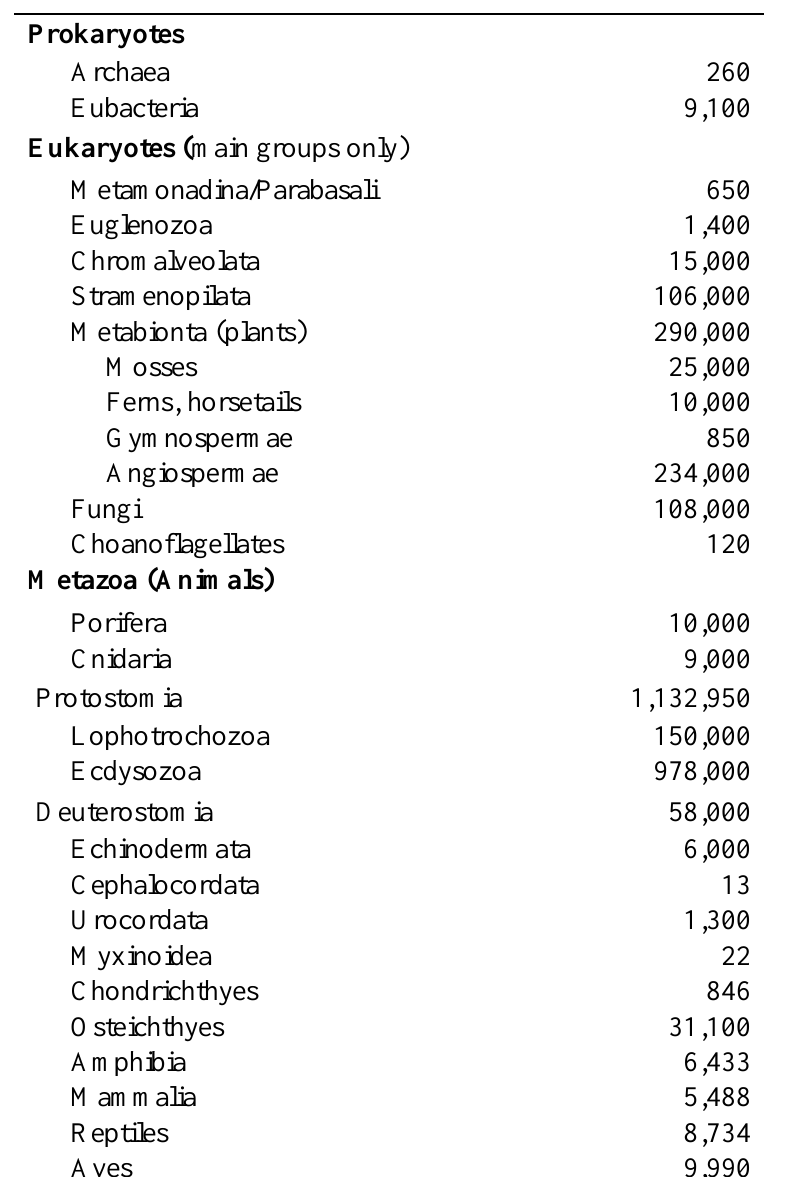
Table 1. Approximate numbers of properly documented [2-5] living species on Earth. Rough estimates of known and undescribed species vary between 5 and 50 million